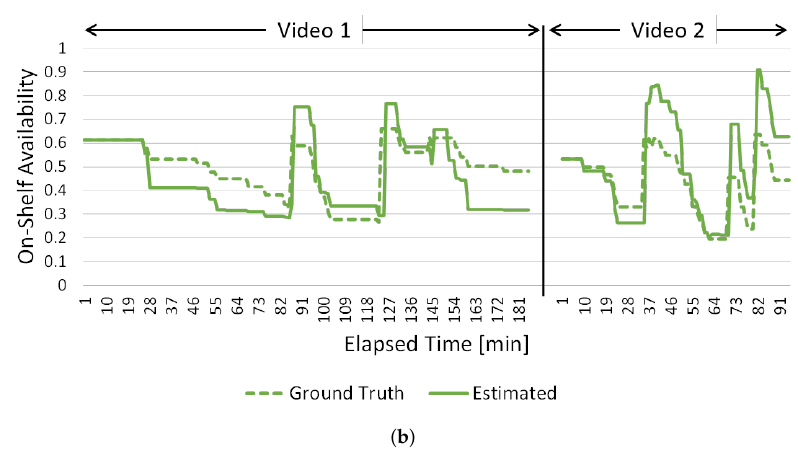
Figure 16. Changes in on-shelf availability every minute in cases of low success rates. ( a ) Results for shelf #1. ( b ) Results for shelf #15.